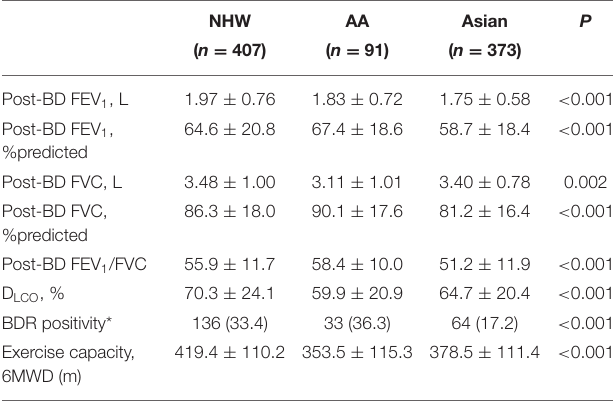
TABLE 1 | Baseline characteristics of participants with ACO by race and ethnicity. NHW AA Asian